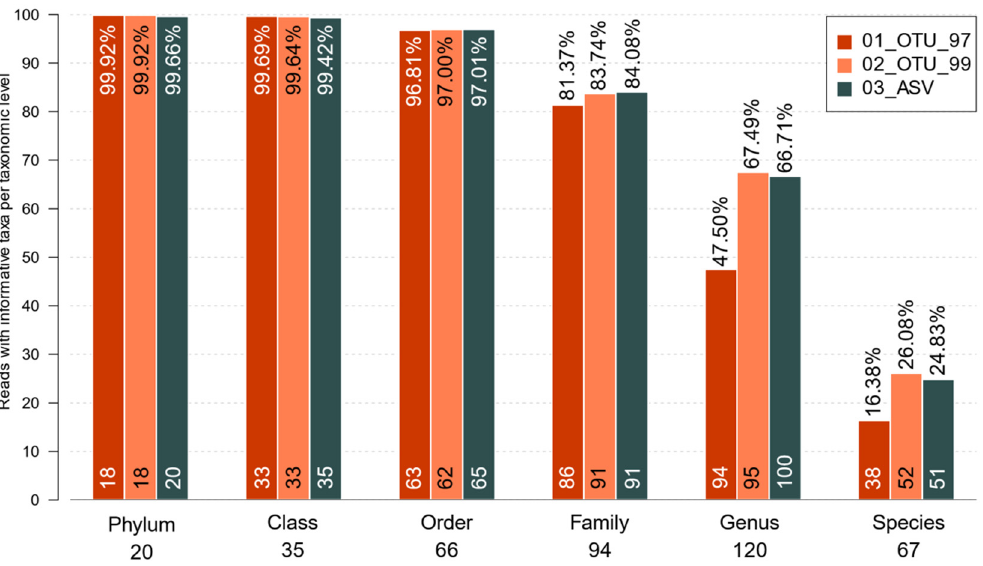
Figure 4. Percentage of reads bearing taxonomically-informative tags for the sets. Only taxa with a valid unambiguous terminal taxonomic node are included in each level. The read percentages are displayed at the top of each bar. Numbers below the taxonomy labels show the total informative tags per level, while numbers on the bottom of each bar show how many are found in each set.